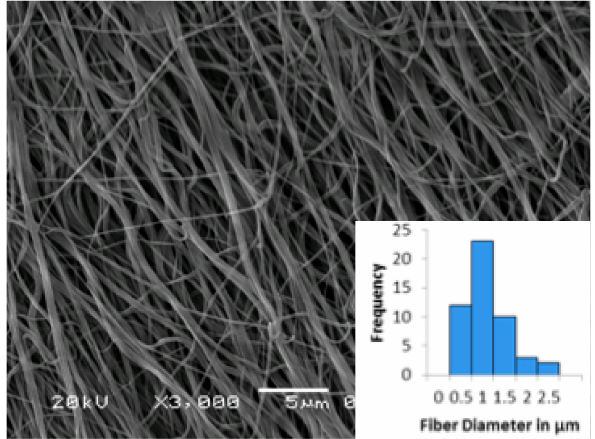
Figure 6. SEM of e-PCL fibers showing porous, fibrous morphology. Inset is the histogram of the fiber diameters of 50 randomly chosen fibers, showing the distribution. The average fiber diameter was 0.82 μ m.